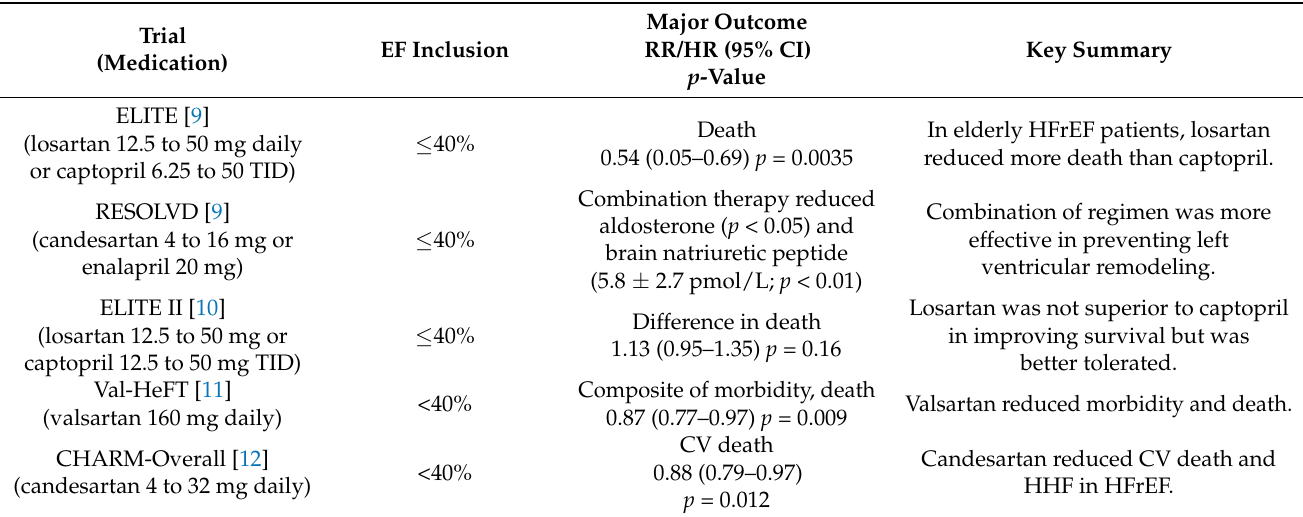
Table 2. Angiotensin receptor blocker heart failure